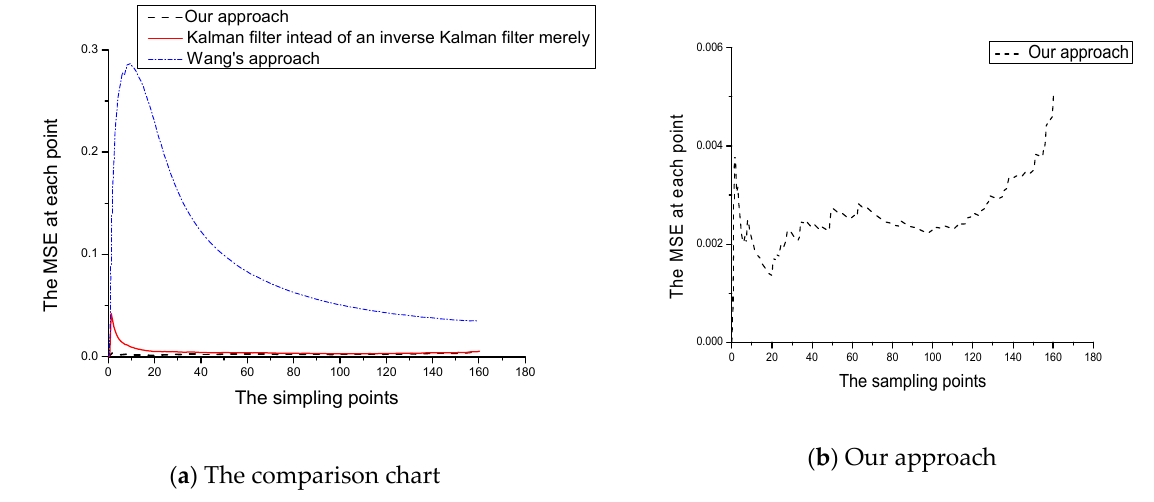
Figure 9. Mean square error (MSE) of expectation for all monitoring points.